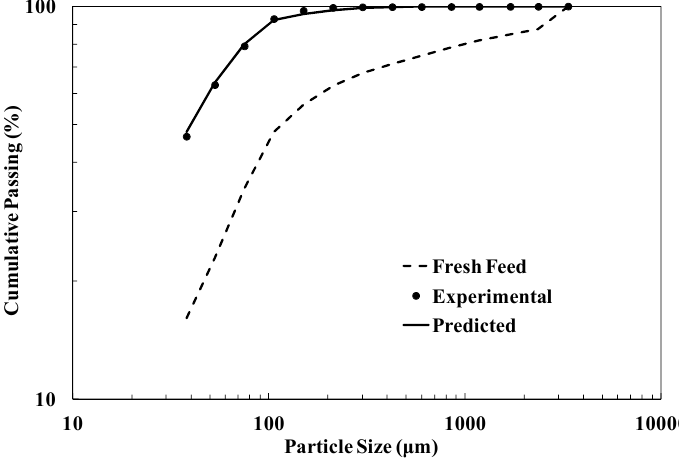
Figure 13. Comparison between experimental and predicted size distribution for pilot plant test P5 (grate discharge) considering the selection function fitted from the batch test with 76% of solids concentration and 100% of slurry filling.